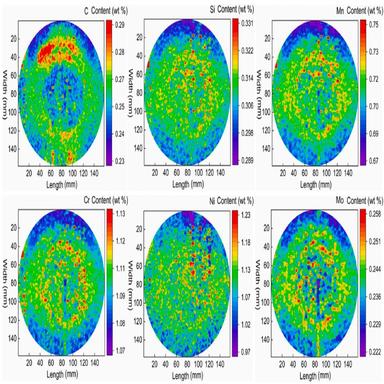
Corrected 2-D content distribution for C, Si, Mn, Cr, Ni, Mo elements in A11 sample by column mapping.